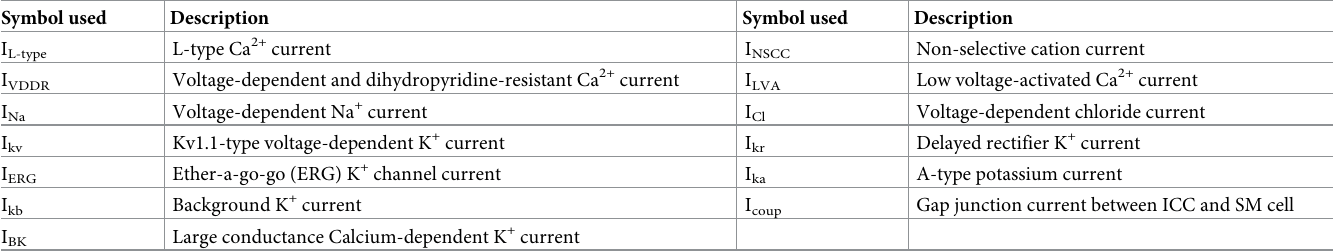
Table 1. Ionic currents in the ICC